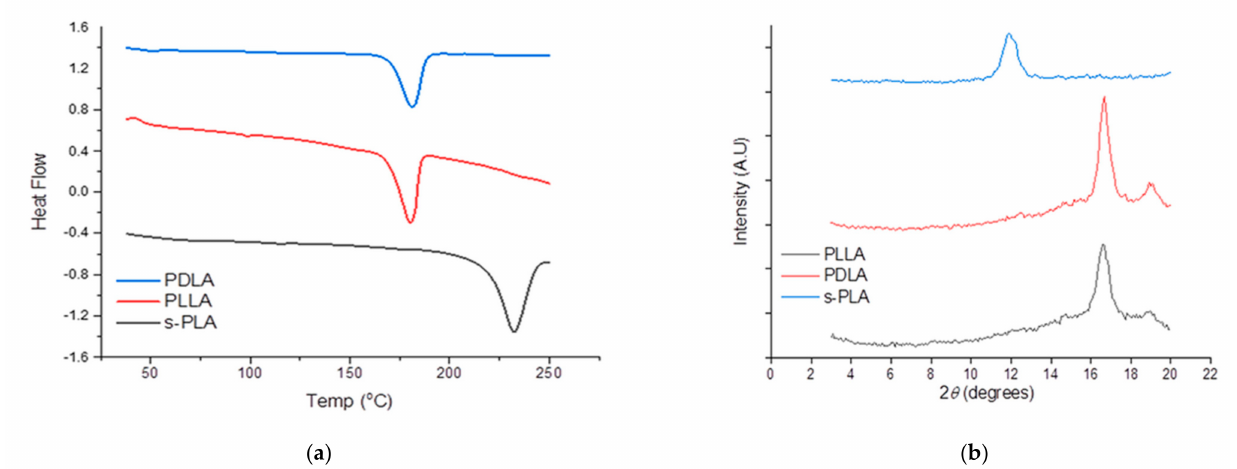
Figure 1. Materials (PLLA, PDLA, and s-PLA) characteristic comparison: ( a ). DSC thermogram; ( b ). X-ray diffraction